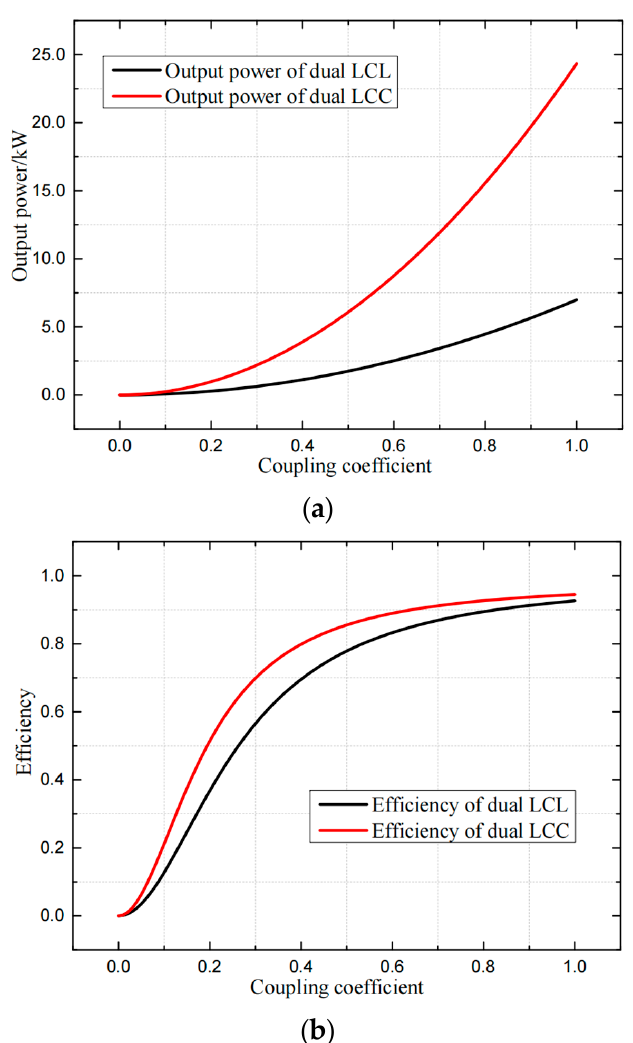
Figure 14. Comparison of power and efficiency characteristics of two topologies: ( a ) maximum output power comparison, ( b ) transmission efficiency comparison.